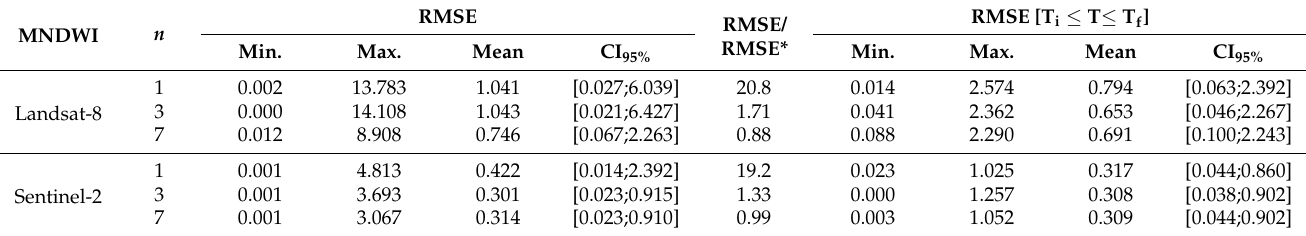
Table 3. Accuracy comparison after constraining threshold variation in a range of RMSE stability.